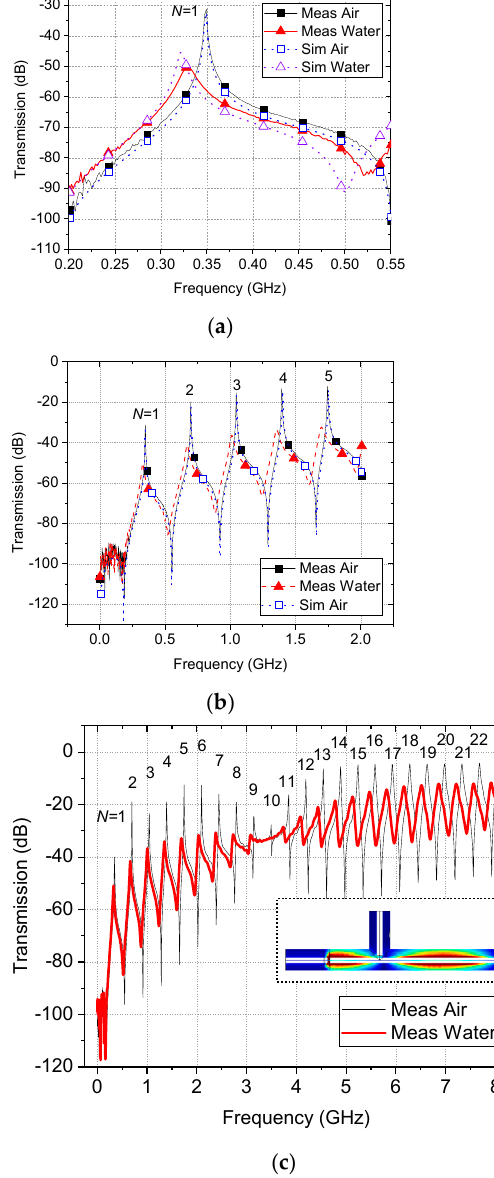
Figure 4. Simulation (air) and measurement (air and water) results, ( a ) at the fundamental resonant frequency of 350 MHz, ( b ) up to 2 GHz showing 5 harmonic resonances, and ( c ) broadband response up to 8 GHz including 22 harmonic resonances, measured with and without water. Inset is the field distribution at 3500 MHz ( N = 10) zoomed in around the two coupling ports.